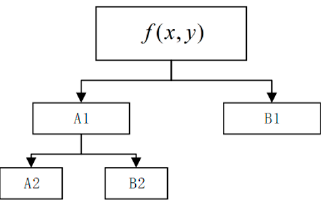
Figure 8. Two-layer wavelet decomposition tree.